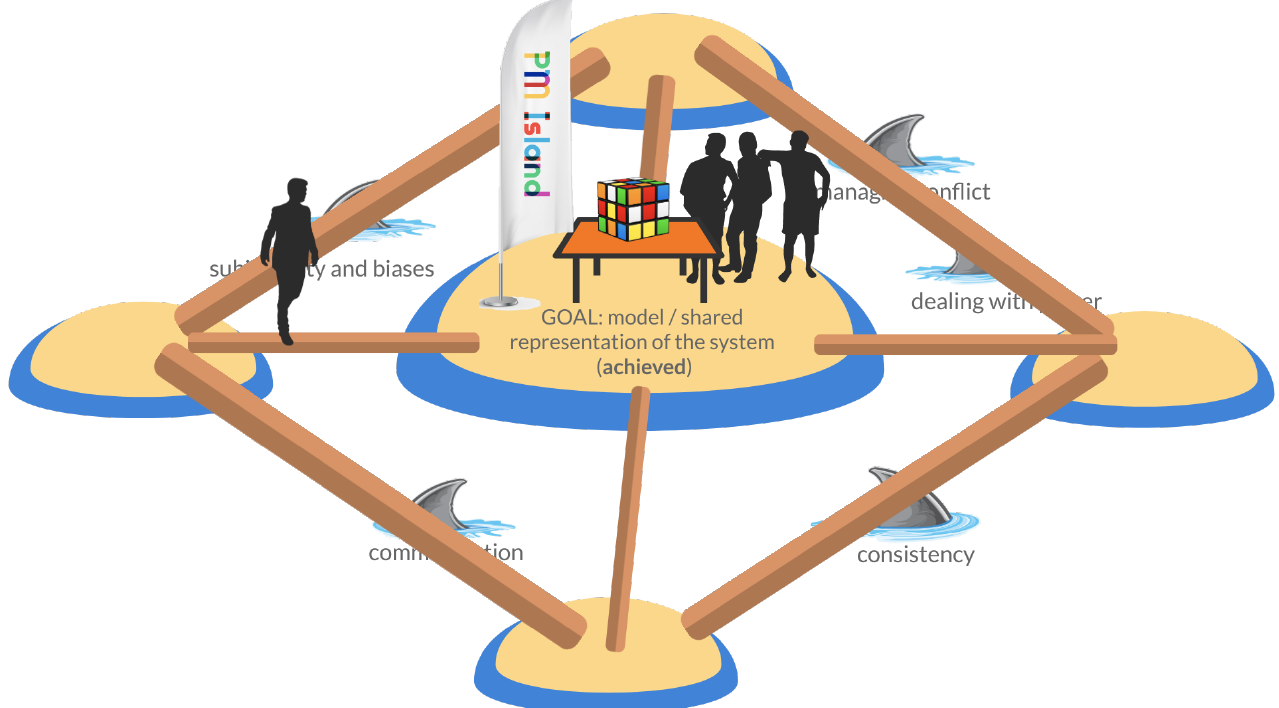
Figure 3. Using transdisciplinary insights to help ‘bridge’ contrasting mental models together and sidestep human barriers, PM can more effectively bring people and their mental models together for a better and shared representation of the